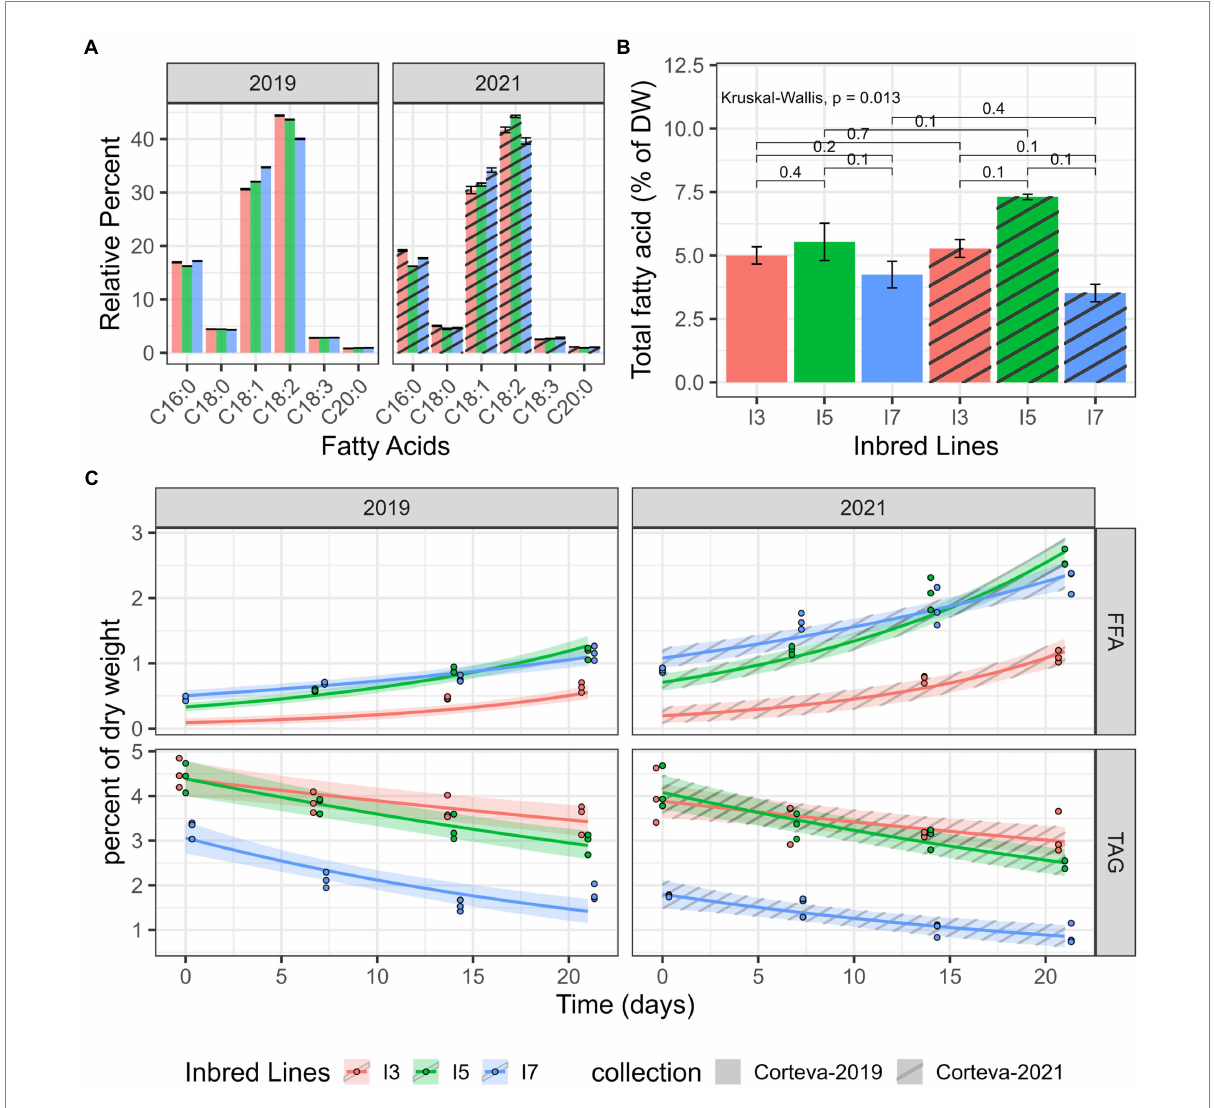
FIGURE 2 Lipid catabolism in milled flour under accelerated-aging conditions. (A) Fatty acid profiles obtained by GC-FID. (B) Total fatty acid quantitation by GC-FID, average over three replicates. Each brace corresponds to a Mann–Whitney test with the resulting value of p indicated above the brace. (C) TAG and FFA levels measured by HPLC-ELSD in two datasets (2019 and 2021). Log-linear hierarchical mixed models were utilized to assess the differences in TAG and FFA levels of these three inbred lines. Points represent observed data, lines represent posterior mean of the predictive distribution, and the ribbon corresponds to the 95% credible interval of the posterior mean predictive